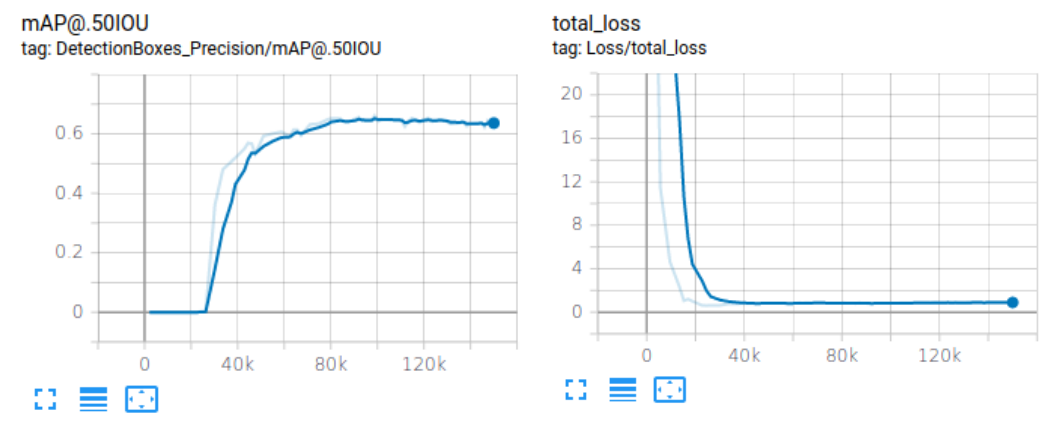
Figure 3. mAP graph and the corresponding training loss graph for Faster R-CNN. The model learns the data while achieving a high accuracy at about 98,700 iterations.